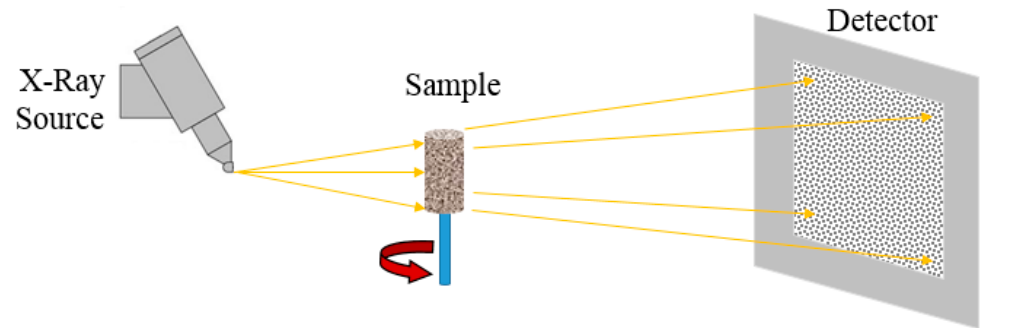
Figure 6. A typical X-ray CT set up with a cone beam configuration. In this configuration the distance between X-ray source and sample can be very small ( ≈ 1 mm).